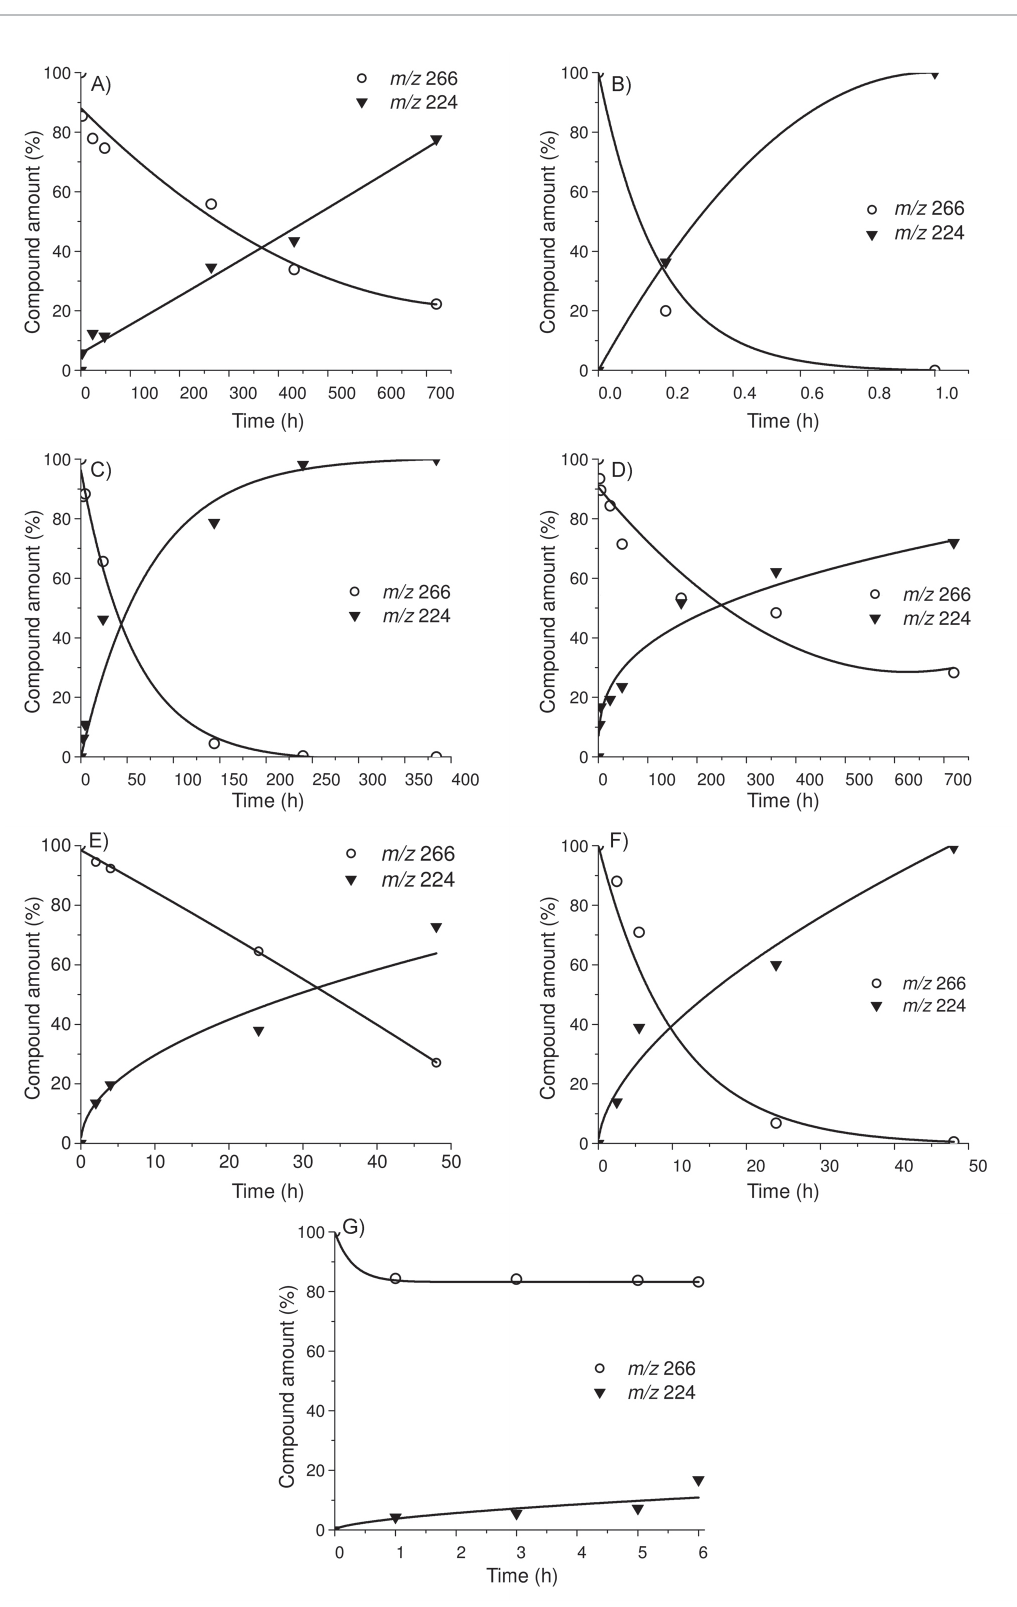
FIGURE 5 - Anisomycin (○) degradation and degradation product (▼) formation under different stress conditions: A) acidic hydrolysis, B) alkaline hydrolysis, C) neutral hydrolysis, D) oxidation, E) thermal degradation (acidic hydrolysis), F) thermal degradation (neutral hydrolysis), G)